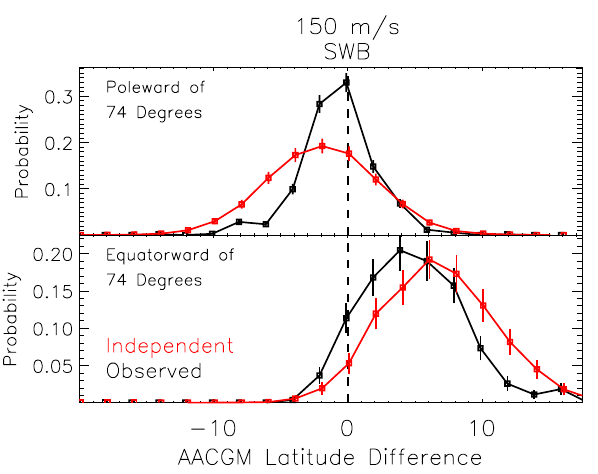
Fig. 4. Probability distributions of latitude differences between the DMSP doc boundary and the 150m/s threshold SWB for the com- bined Goose Bay and Finland SuperDARN radars in the 12:00– 18:00 MLT region. The upper panel represents the results from comparisons using SWBs located poleward of 74 ◦ , whereas the lower panel represents the results from comparisons using SWBs located equatorward of 74 ◦ . The black distributions represent the observed distributions. The red distributions represent the predicted distributions that would occur if the SWB and DMSP doc observa- tions were independent.